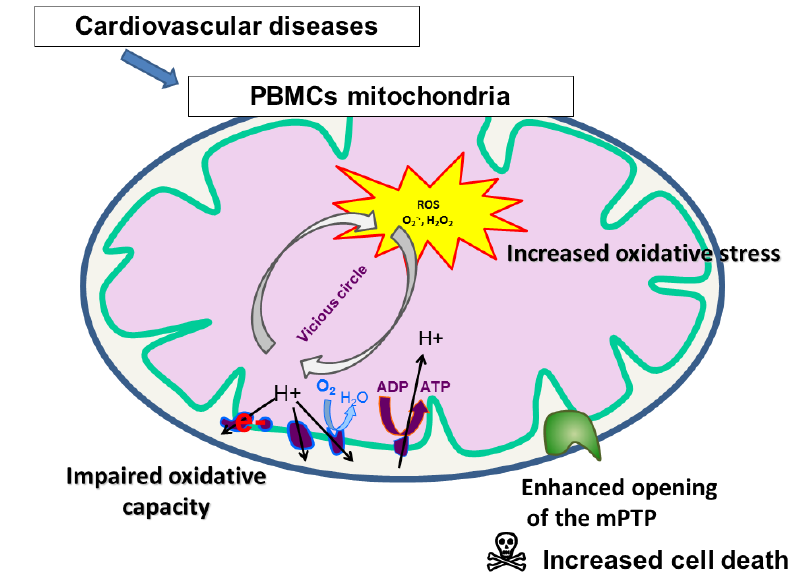
Figure 2. Mitochondrial alterations in PBMCs or platelets during cardiovascular diseases.